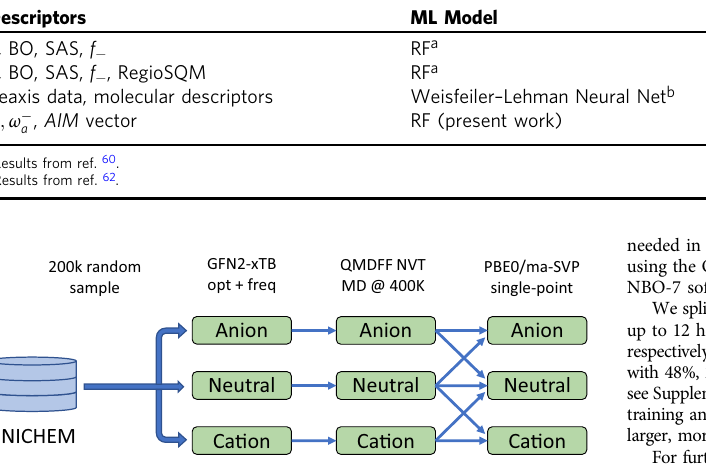
Fig. 6 The work fl ow for data set generation for the neutral and charged molecular species. The molecules to construct the training data set were sampled from the UNICHEM database. Potential energy surface was sampled with GFN2-XTB and QMDFF molecular dynamics. Reference QM energies and charges obtained at PBE0/ma-def2-SVP level. The lines represent data fl ow during data